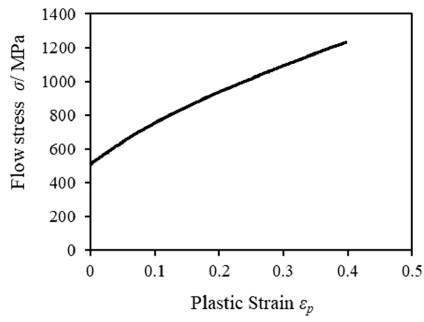
Figure 2. FEM simulation model.